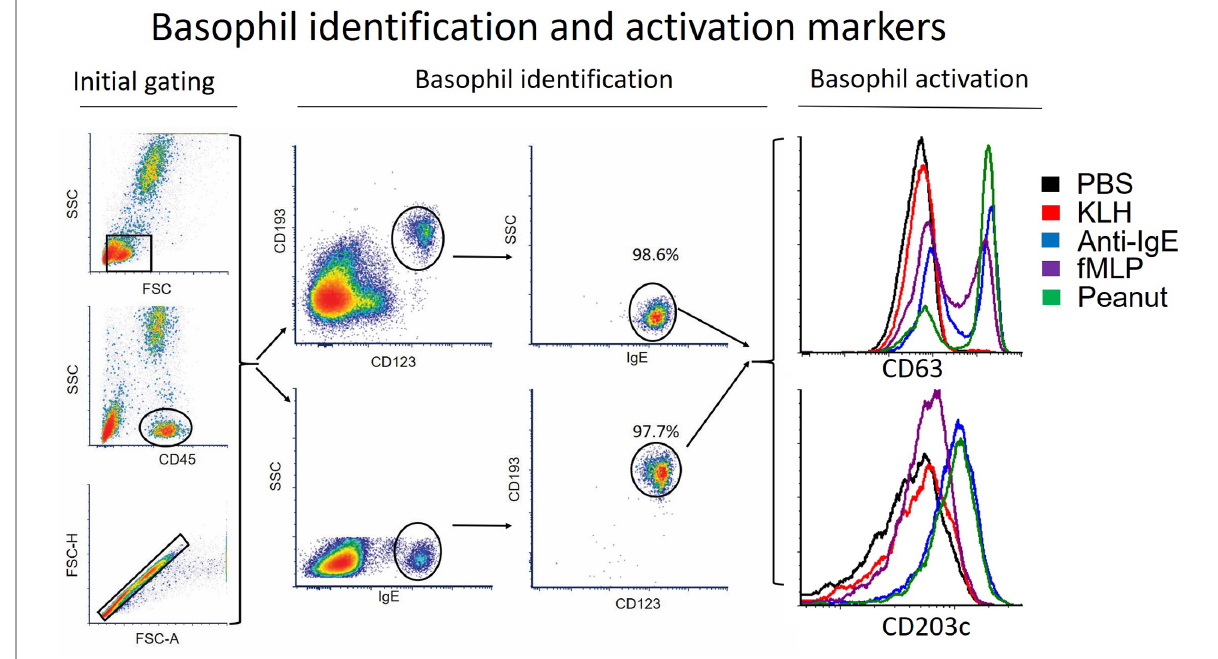
FIGURE 2 Determine basophil activation by fl ow cytometry. The initial gating aims at isolating singlets and removing eosinophiles, neutrophils and to some extent monocytes and DC ’ s. The subsequent basophil identi fi cation where basophils are identi fi ed based on their surface markers. Here two approaches are shown, CD123/CD193 and IgE/SSC. Lastly the activation determined by CD63 and CD203c are shown for the two negative controls (PBS and KLH), the two positive controls (Anti-IgE and fMLP) and the peanut